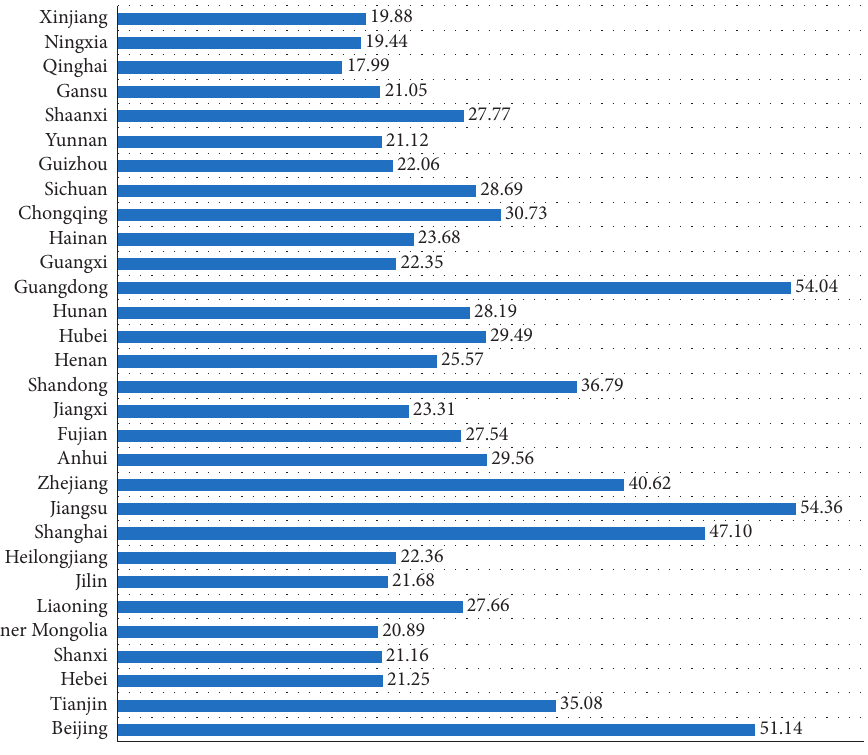
Figure 1: Average value of the urban innovation level of 30 provinces and cities in China